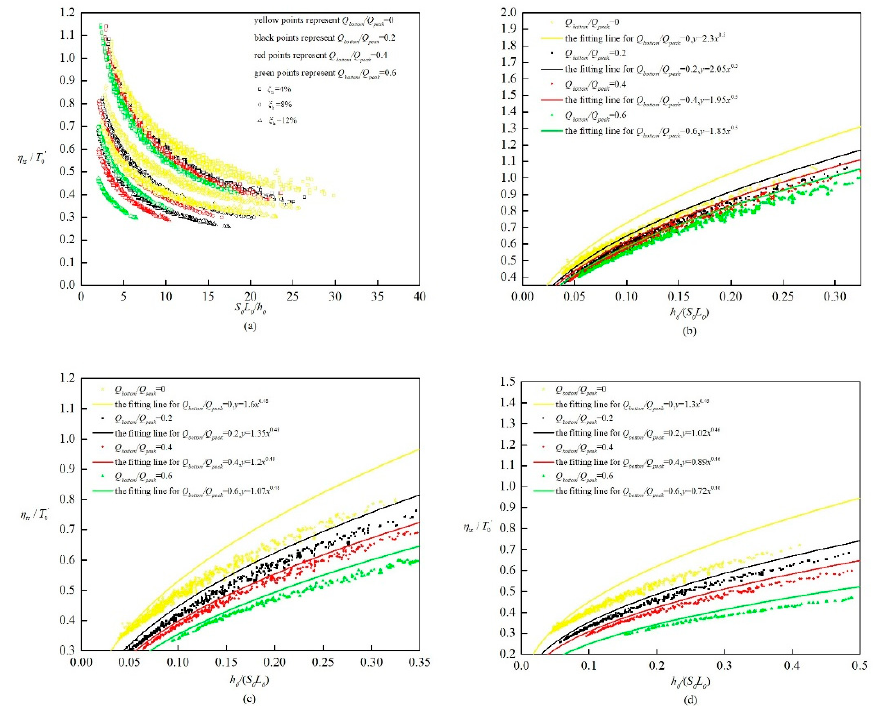
Figure 7. The comparison between the adjusted line expressed in Table 5 and the corresponding group